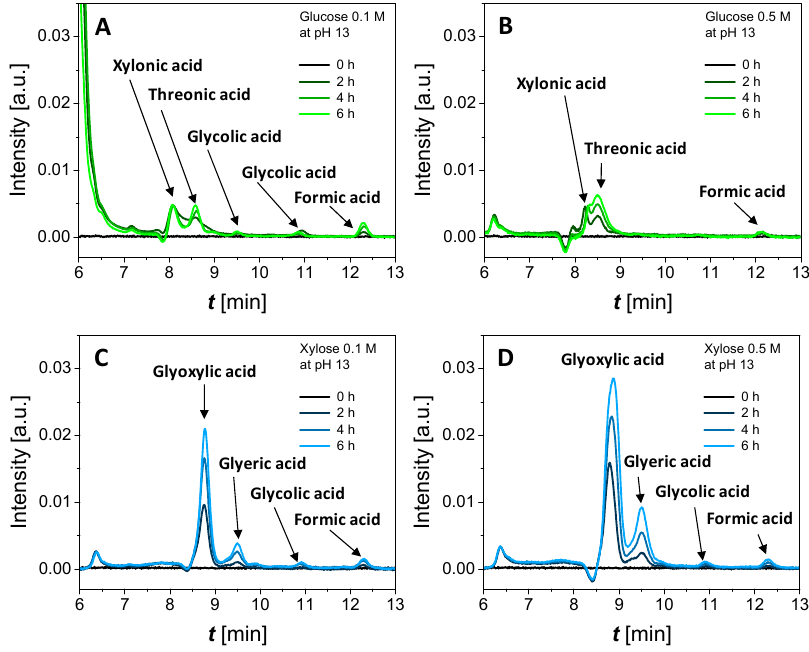
Figure 11. Chromatograms recorded as a function of time for 6 hours aging of ( A ) 0.10 mol L − 1 glucose,